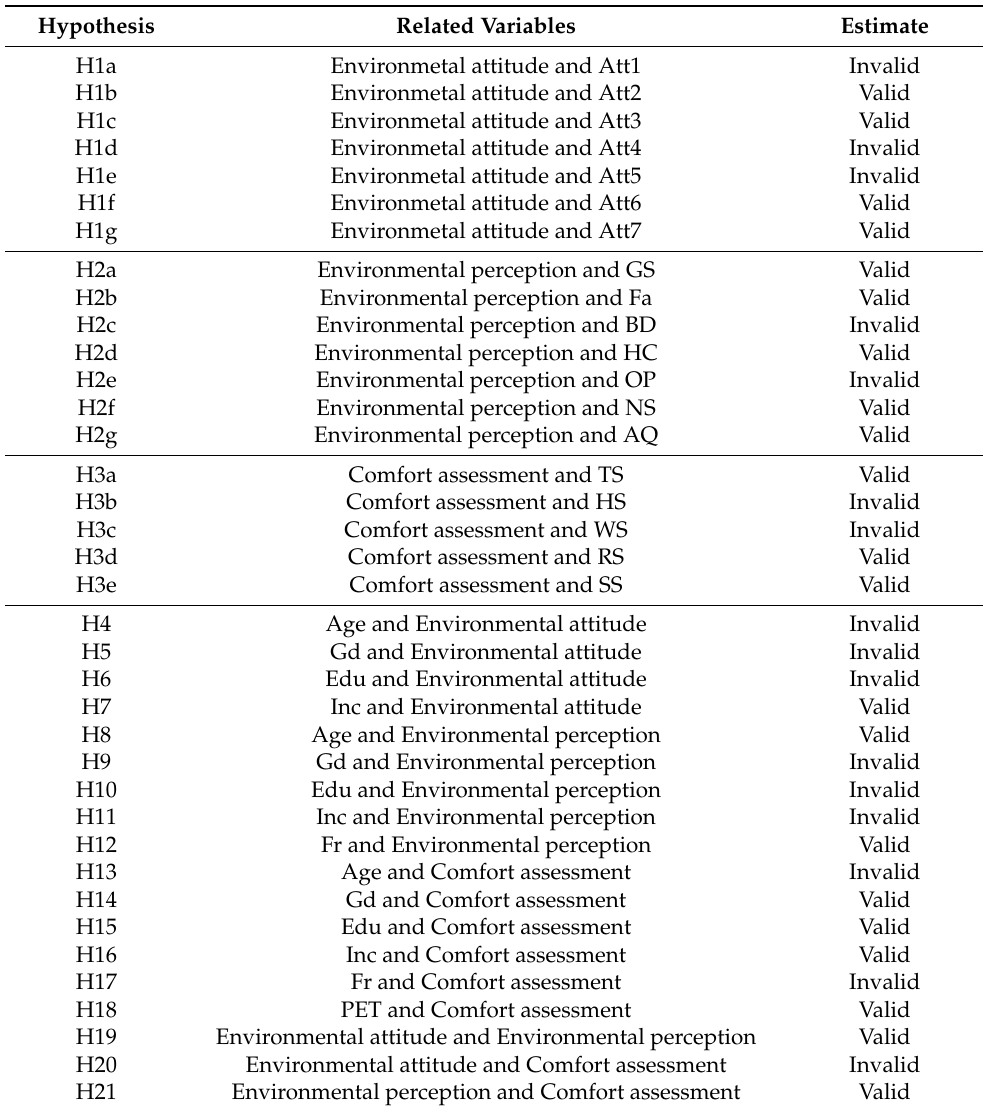
Table 5. Verification result of hypothetical relationships.